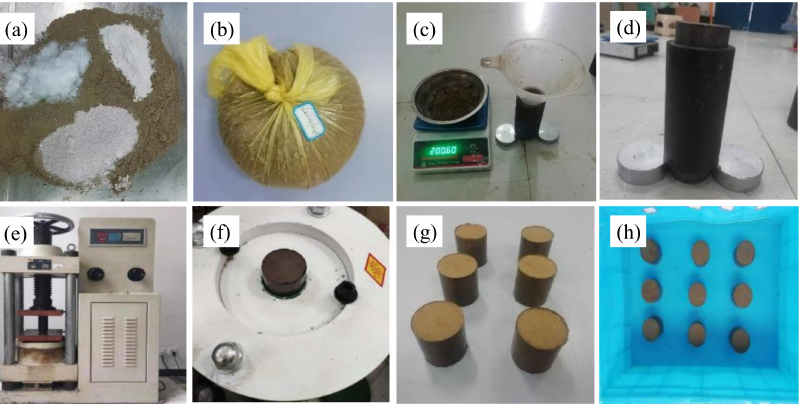
Figure 3. Sample production process: ( a ) Mixture mixing; ( b ) Mixture wetting; ( c ) Mixture weighing; ( d ) Sample making; ( e ) Sample compaction; ( f ) Sample demoulding; ( g ) Sample after demoulding; ( h ) Sample during